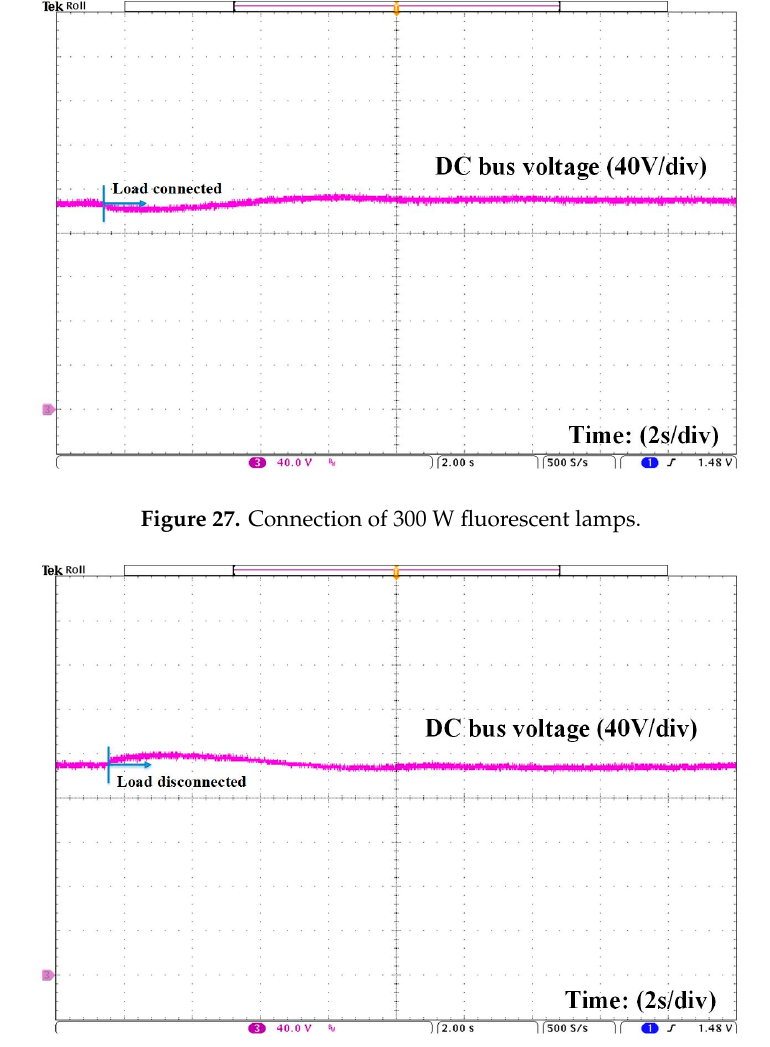
Figure 26. Disconnection of 115 W LED lamp.